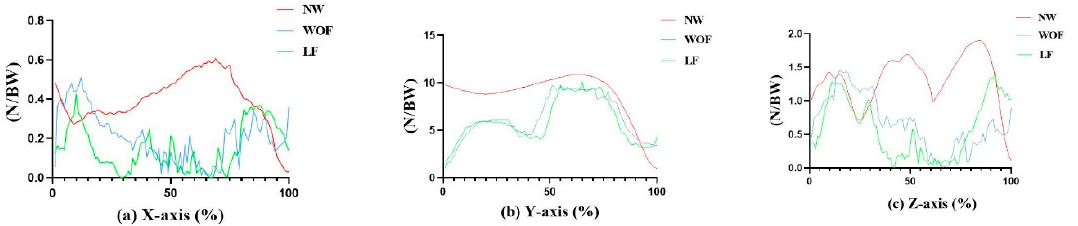
Figure 4. Comparisons of the GRF during NW (red line), WOF (blue line) and LF (green line): ( a ) GRF on the X-axis, ( b ) GRF on the Y-axis, and ( c ) GRF on the Z-axis.